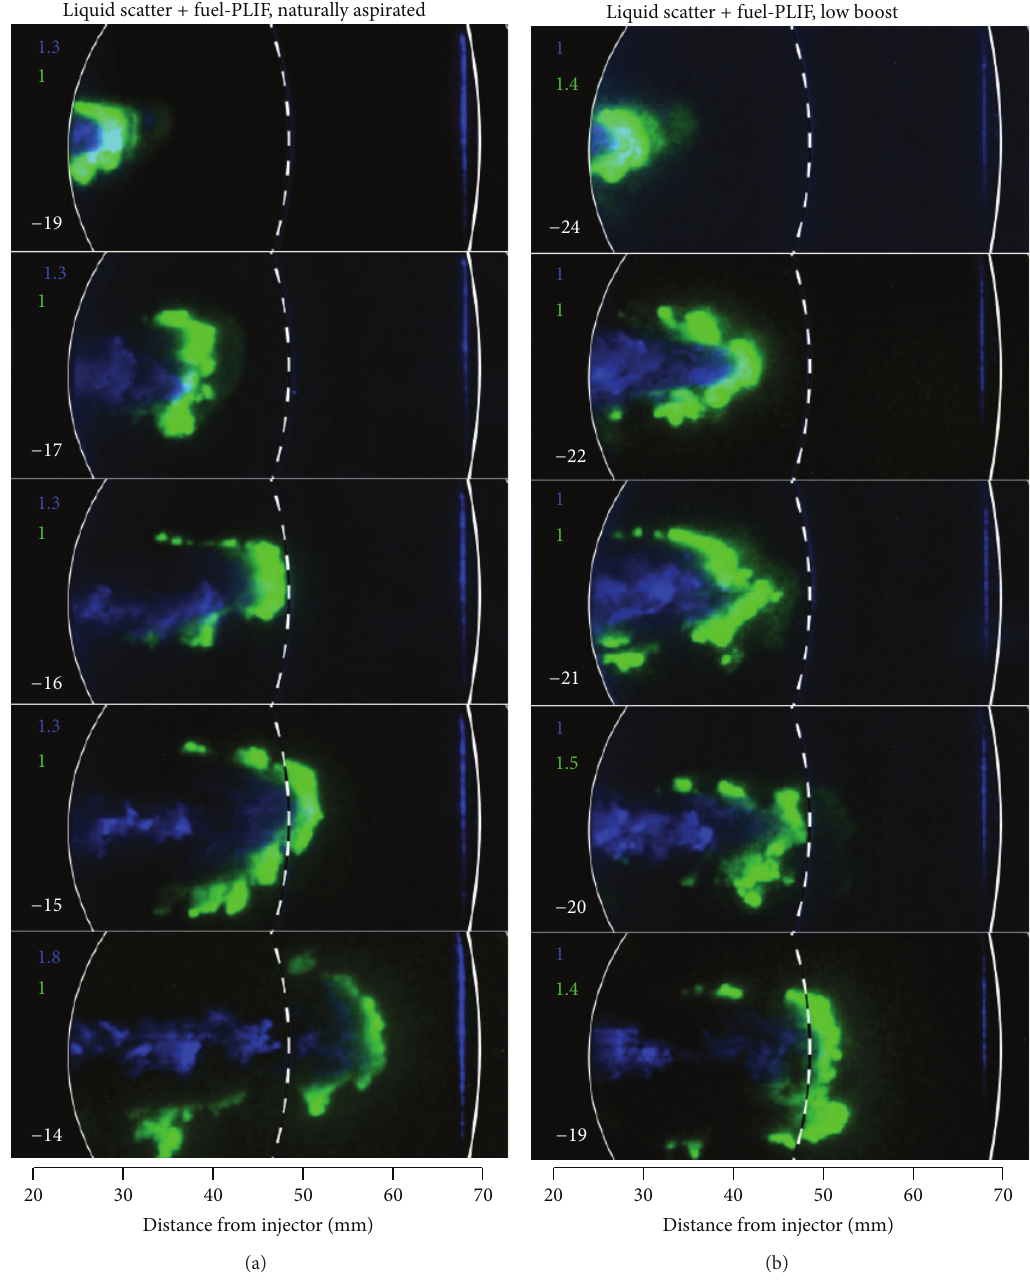
Figure 3: Liquid fuel (blue) and vapor fuel perimeter (green) for naturally aspirated (a) and low-boost (b) conditions (the dashed line is the edge of piston bowl-rim)